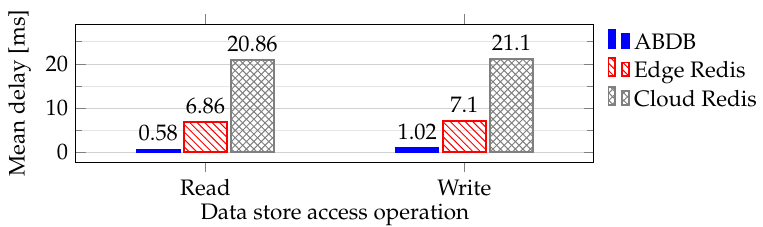
Figure 15. Data read and write delay of the autonomous driving application in case of different data store